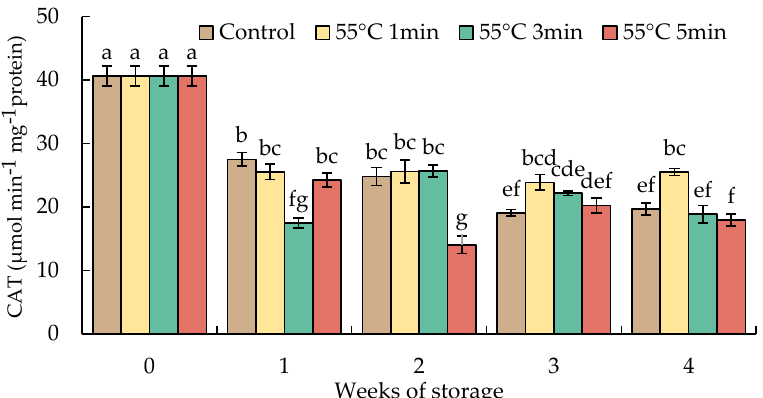
Figure 10. Effect of hot water treatment (55 ◦ C for 1, 3, 5 min) on the activity of catalase (CAT) in red sweet pepper fruit during storage at 10 ◦ C. Data represent means ± S.E. (n = 3). Different letters on bars are significantly different ( p < 0.05).